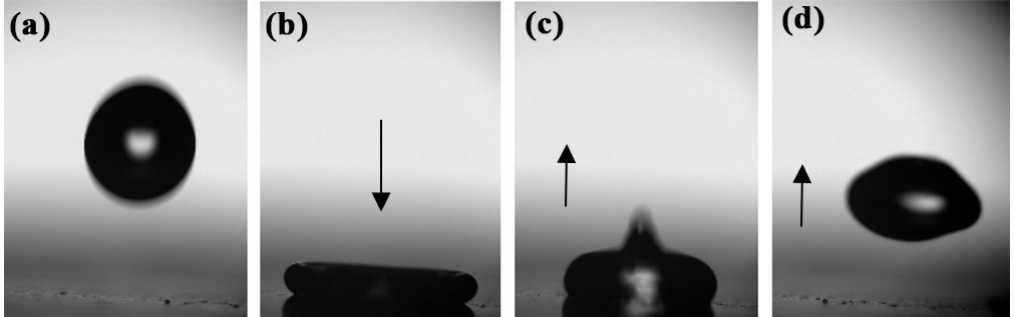
Figure 5. Time-lapse photographs of water droplets bouncing on the PTFE + 30%SiO 2 superhydro- phobic coating (Droplet sizes of 5 μL). ( a ) Droplets falling, ( b ) The droplets fall and make contact with the coating, ( c ) Droplets bounce and ( d ) The droplets spring up and leave the coating.